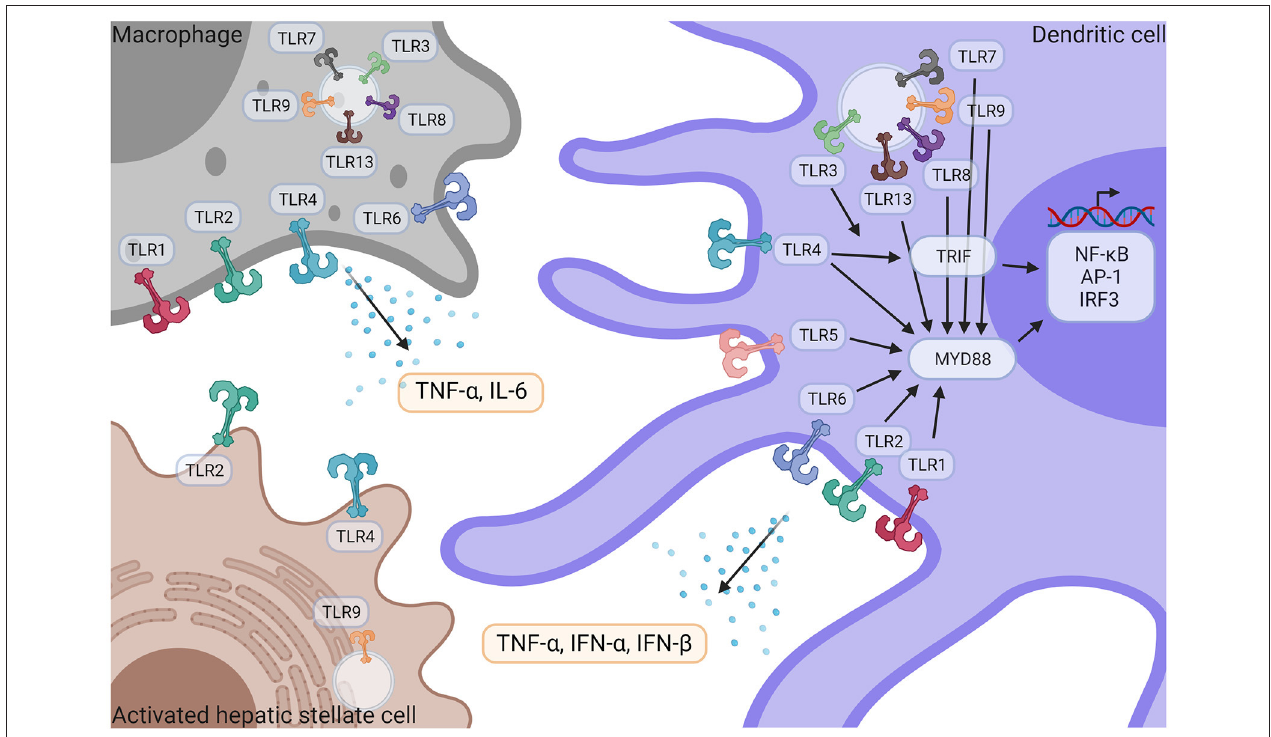
FIGURE 3 | TLR signaling in liver immune pathogenesis. Macrophages and DCs express TLR1, − 2 − 3 − 4 − 6 − 7 − 8 − 9 − 13 and TLR5 is only expressed in DCs. HSCs express TLR2, TLR4, and TLR9. Following activation by their respective ligands, TLRs induce TRIF and/or MyD88 signaling pathways, leading to the activation of NF- κ B, AP-1, and IRF3 transcriptional factors, followed by the release of pro-inflammatory cytokines such as TNF- α , IFN- α , IFN- β and IL-6. IFN- α , Interferon α ; IFN- β , Interferon β ; IL-6, Interleukin 6; NF- κ B, nuclear factor kappa-light-chain-enhancer of activated B cells; TNF- α , Tumor necrosis factor α ; TLR, Toll like receptor. Created with